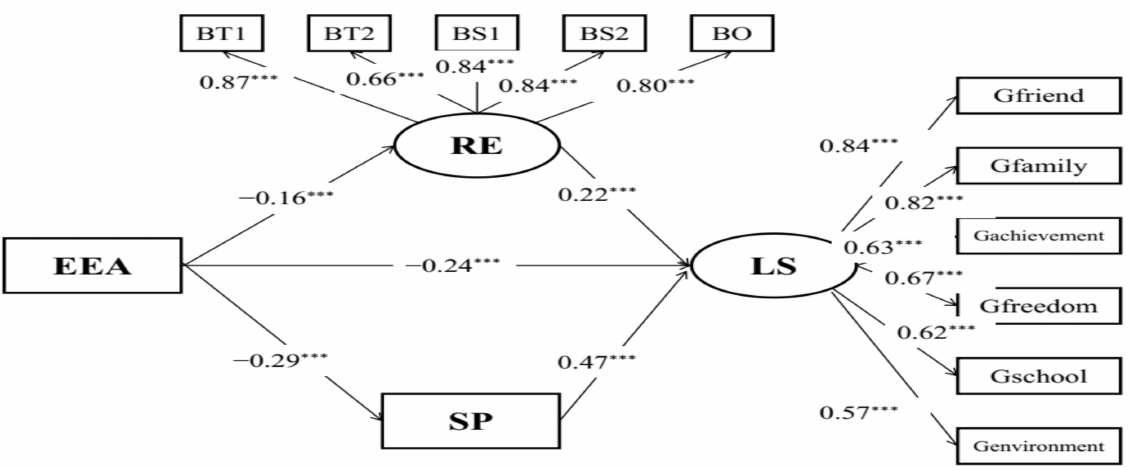
Figure 5. Mediation model of emotional abuse, life satisfaction, resilience, and social support. EEA: emotional abuse; BT1: tenacity 1; BT2: tenacity 2; BS1: strength 1; BS2: strength 2; BO: optimism; LS: life satisfaction; RE: resilience; SP: social support; *** p < 0.001.